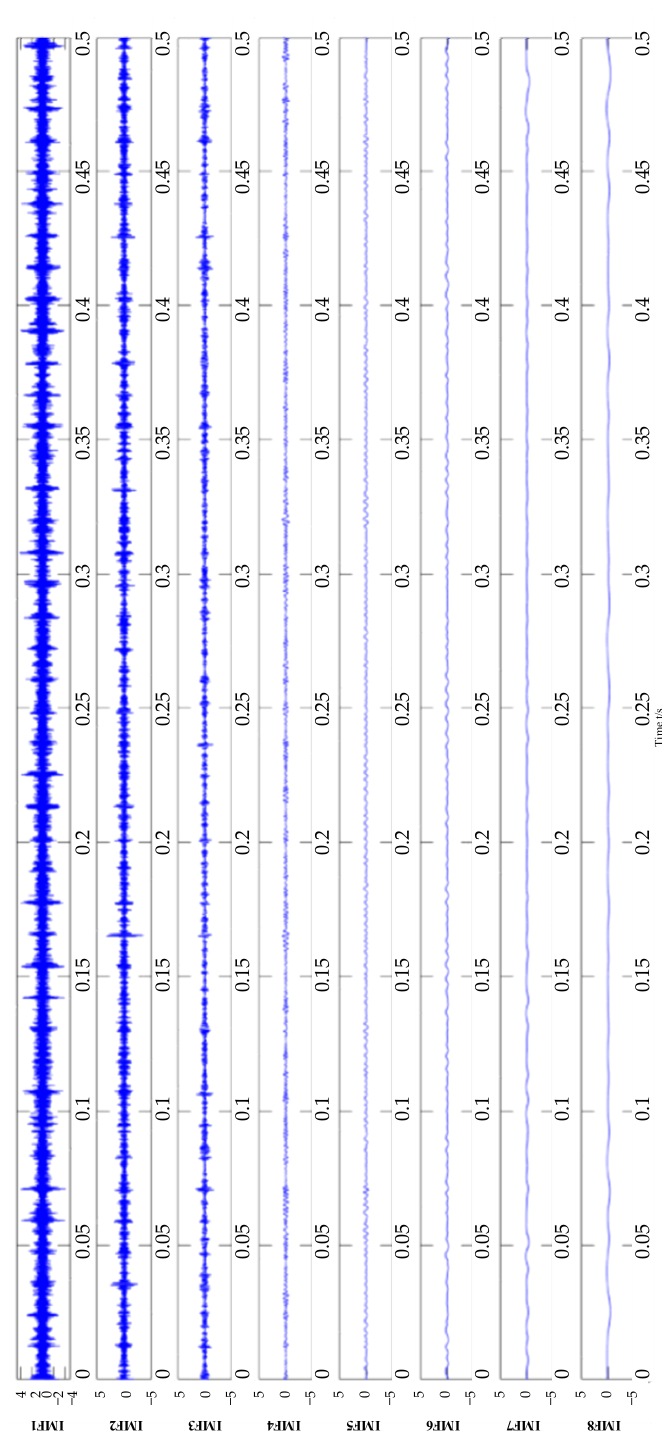
denoising. The number of atoms trained in each segment is 200, and finally the hard threshold is set at 0.2. The result is shown in Figure 18.